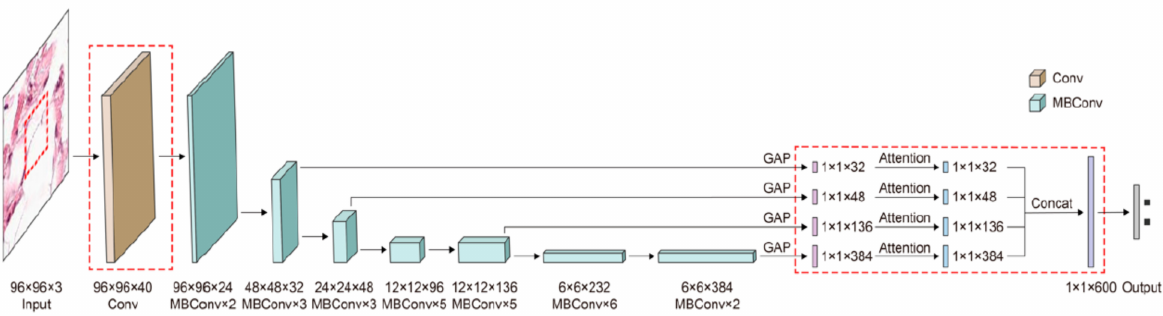
Figure 19. EfficientNet architecture [107].